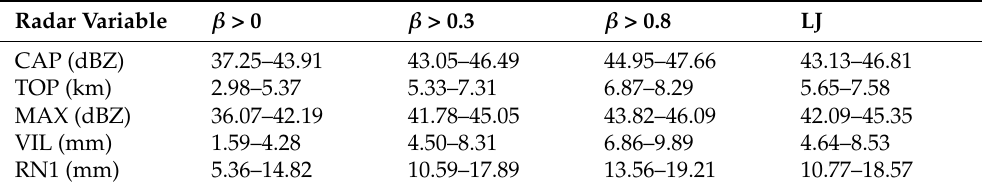
Table 3. Bottom and top limits of the boxplots of “a” parameter shown in Figure 8, compared with the obtained for the days with